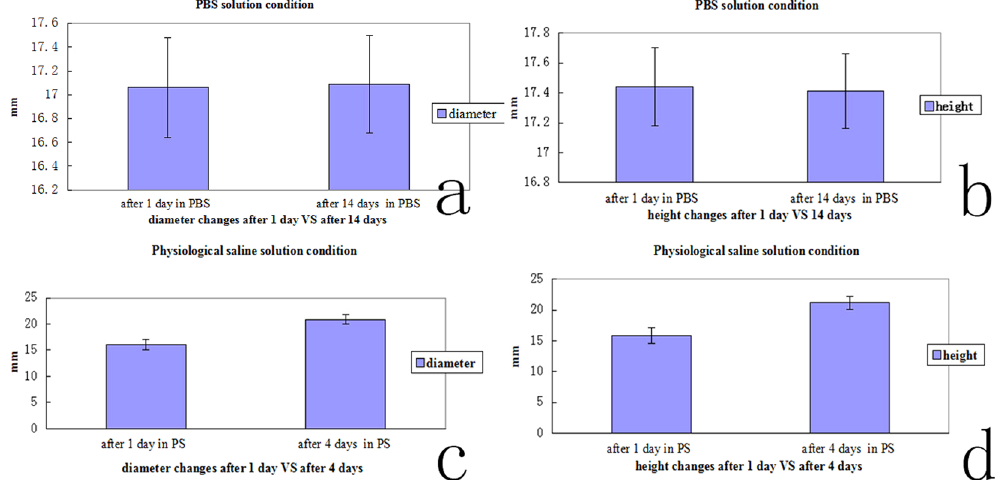
Figure 3. ( a ) The diameter for the PBS solution conditions (after 1 day immersion in PBS vs. after14 days immersion in PBS) was not significantly different (p > 0.05). ( b ) the height for the PBS solution conditions (after 1 day immersion in PBS vs. after14 days immersion in PBS) was not significantly different (p > 0.05). ( c ) the diameter of SF/PU hydrogel was significantly different (after 1 day immersion in the saline solution vs. after 4 days immersion in the saline solution, p < 0.05 at all the specimens levels). ( d ) the height of SF/PU hydrogel was significantly different (after 1 day immersion in the saline solution vs. after 4 days immersion in the saline solution, p < 0.05 at all the specimens levels).